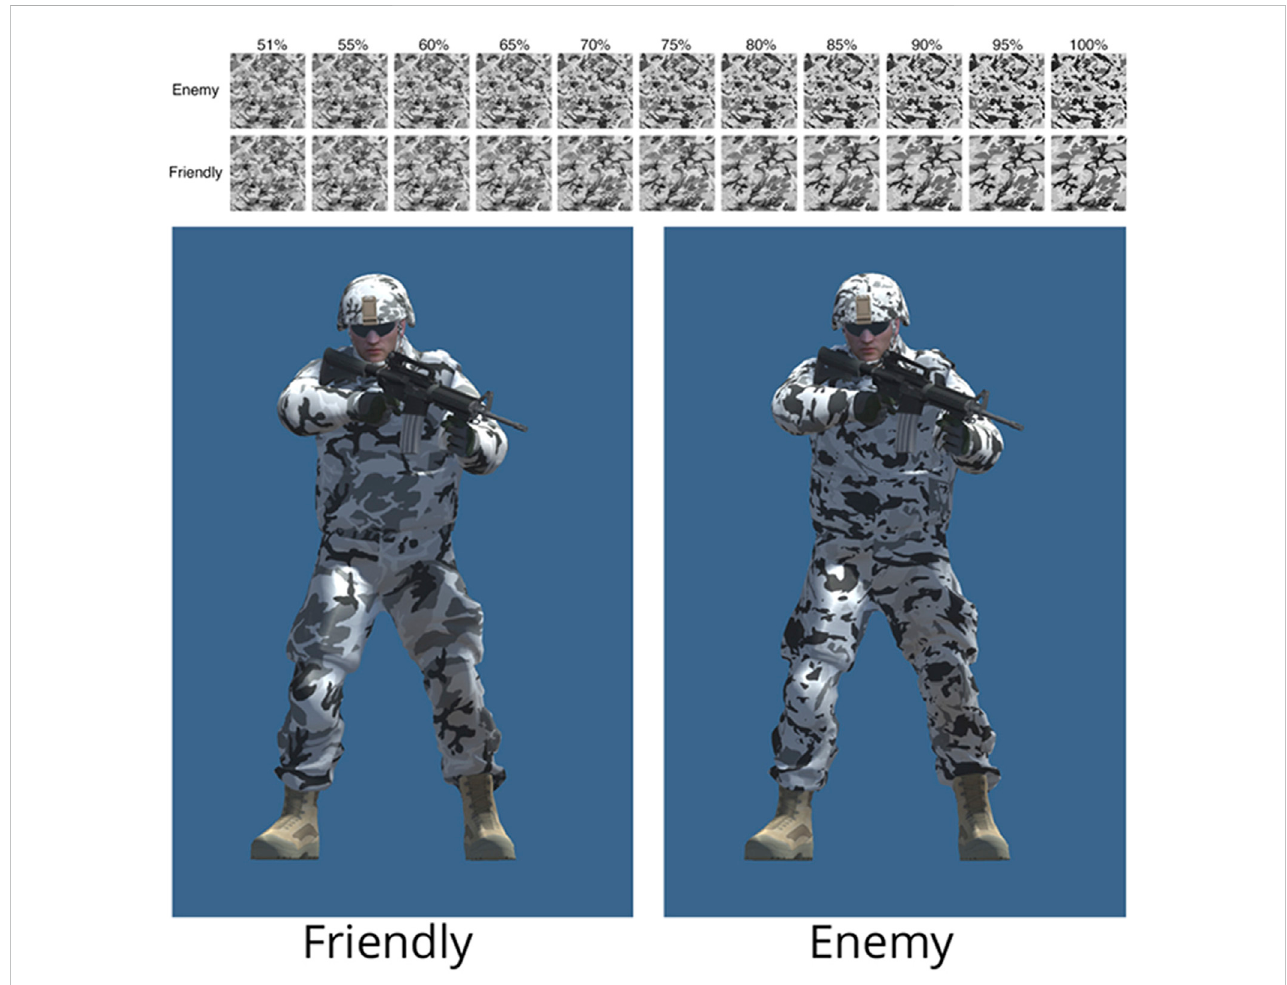
FIGURE 1 An example (from test version 1) of the eleven levels of opacity shifting for the enemy and friendly camou fl age pattern pilot testing (upper panel), and an example of the original (100%) versions of the friendly and enemy patterns adorning an avatar.